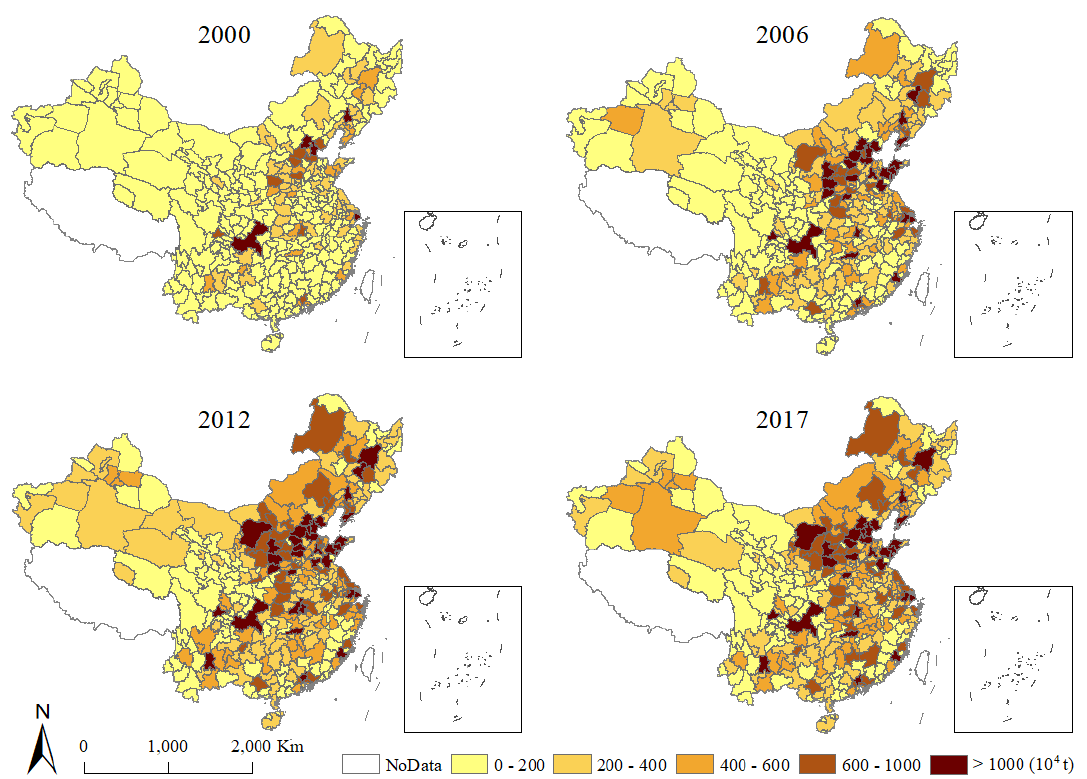
Figure 4. Spatial distribution of carbon emissions at the city level for the periods 2000–2017.